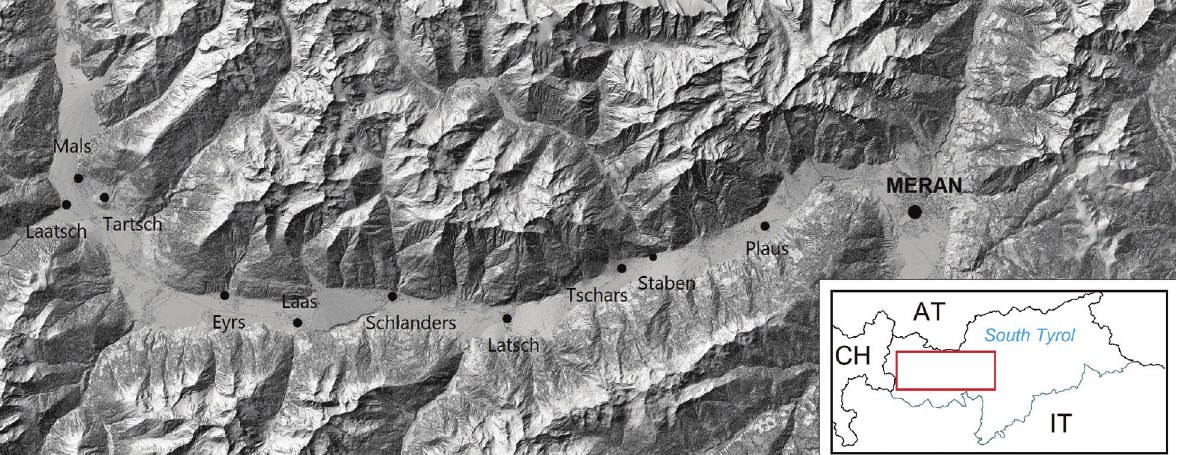
Figure 2. The investigated study area in the Vinschgau (South Tyrol, Italy) at the south-facing slopes from Mals and Laatsch to Plaus, spanning a length of approximately 40 km (Source: Office for Geology and Building Materials Testing of the Autonomous Province of Bolzano and ISPRA (big map); Eurostat (https://ec.europa.eu/eurostat/ web/gisco/geodata/reference-data/administrative-units-statistical-units) EuroGeographics for the administrative boundaries (small